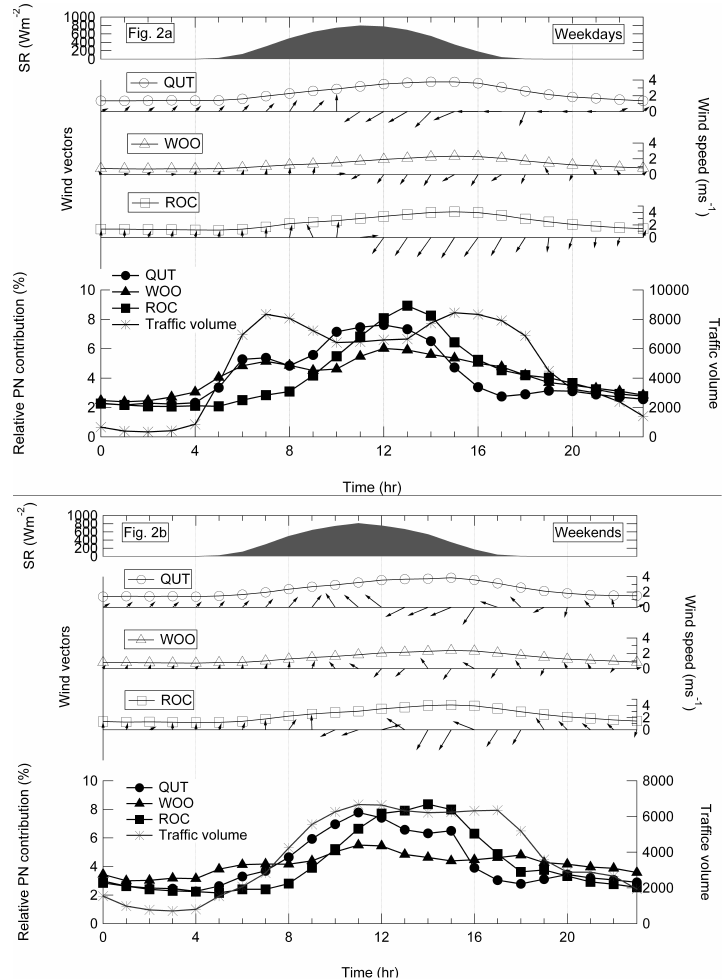
Fig. 2. Average diurnal variation of parameters measured for (a) weekdays and (b) weekends. From bottom to top: (i) relative PNC measured at three sites, together with traffic volumes recorded at QUT; (ii) wind vectors measured at the three sites; and (iii) solar radiation (SR) measured at